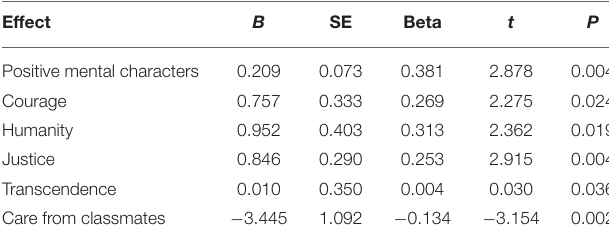
TABLE 4 | Multiple liner regression analysis of determinants of humanistic care ability for nursing students, Changsha, Hunan, China ( N = 981).